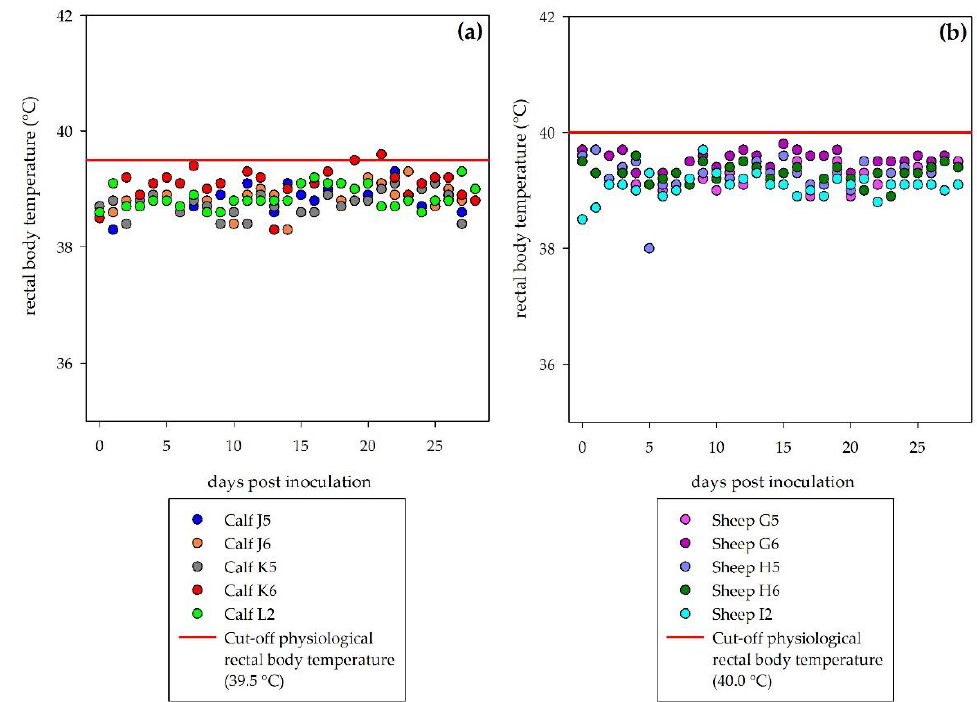
Figure 1. Rectal body temperature during the observation period: No fever was detected in inoculated cattle ( a ) or sheep ( b ). Physiological rectal body temperatures can rise up to 39.5 °C in calves and up to 40.0 °C in sheep (illustrated by the red line in each graph), short-term higher temperatures may be animal handling/excitement artefacts.